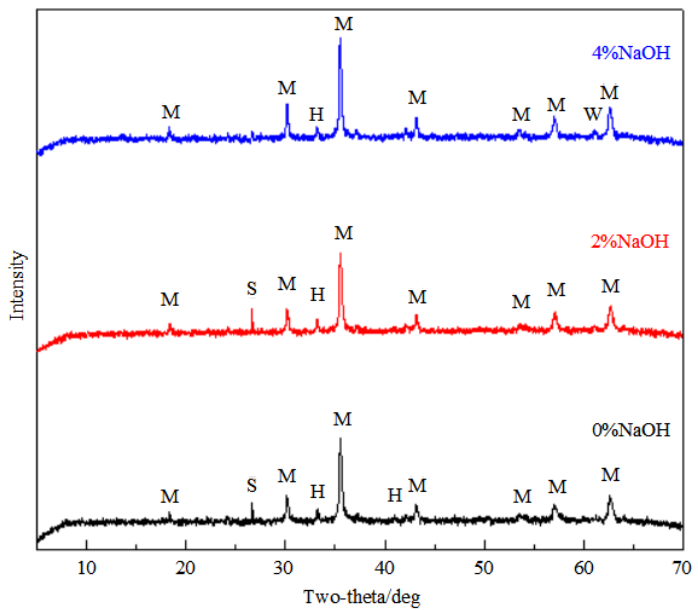
The XRD patterns of iron ore concentrates obtained at different NaOH dosages are shown in Figure 10. The main phases in the concentrate without NaOH are hematite, magnetite, and quartz. With an increase in the NaOH dosage, the quartz peak disappears.